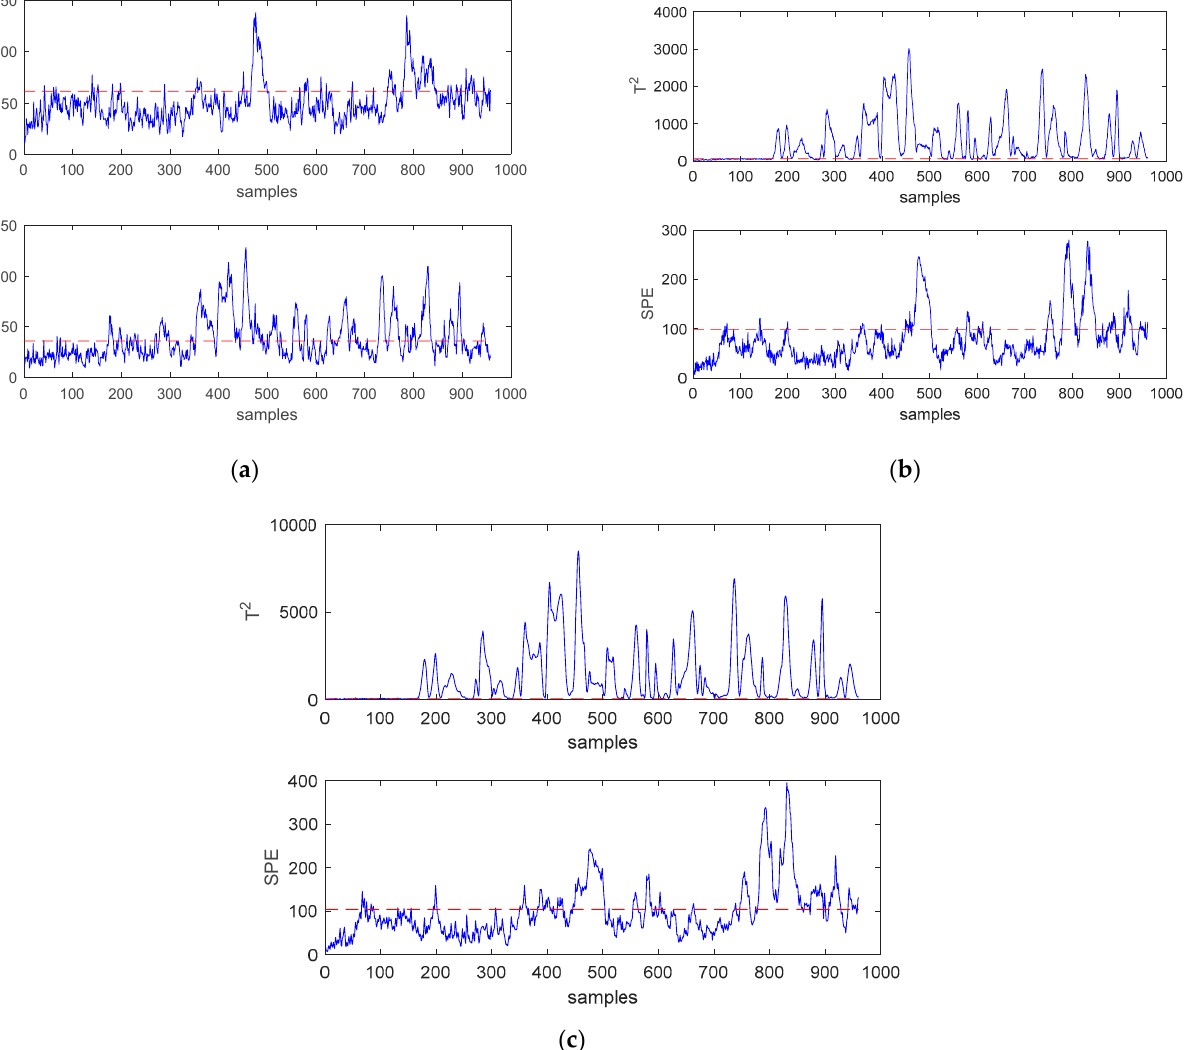
Figure 5. ( a ) Monitoring charts of PCA for fault 16. ( b ) Monitoring charts of GLPP for fault 16. ( c ) Monitoring charts of SWWD-GLPP for fault 16.